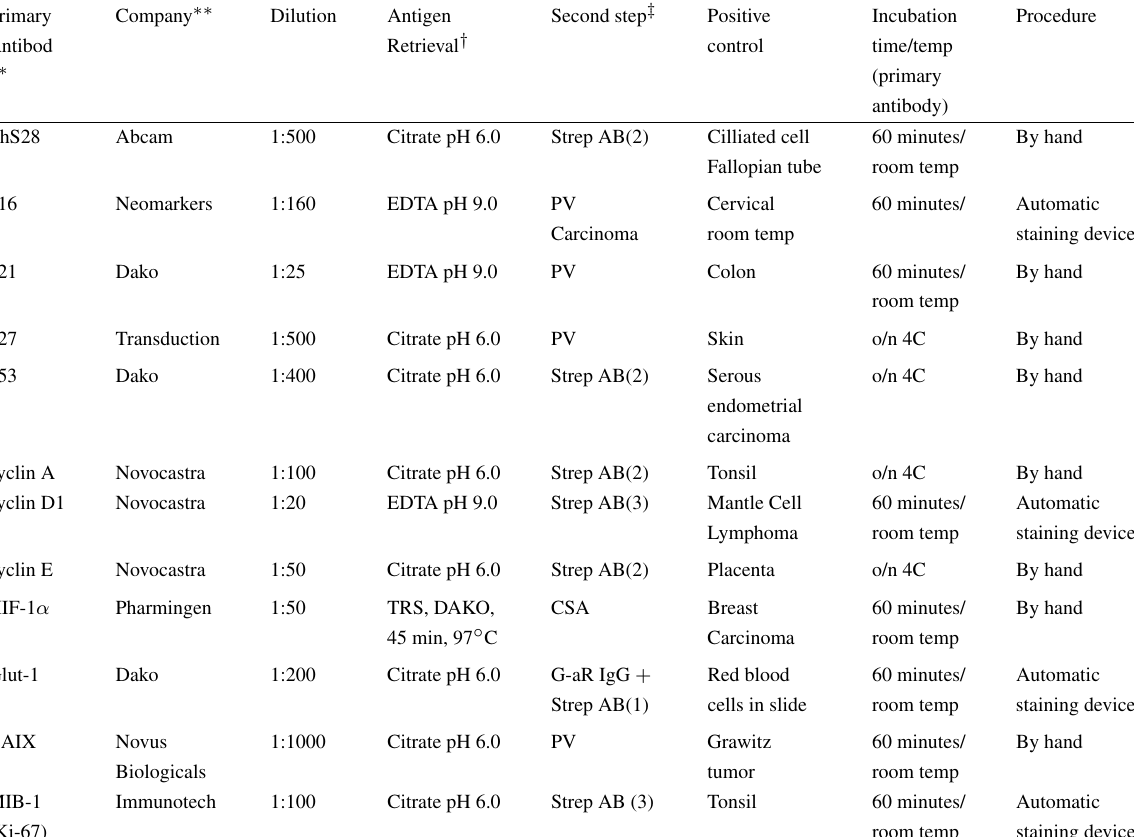
Overview of the antibodies used and tissue processing details